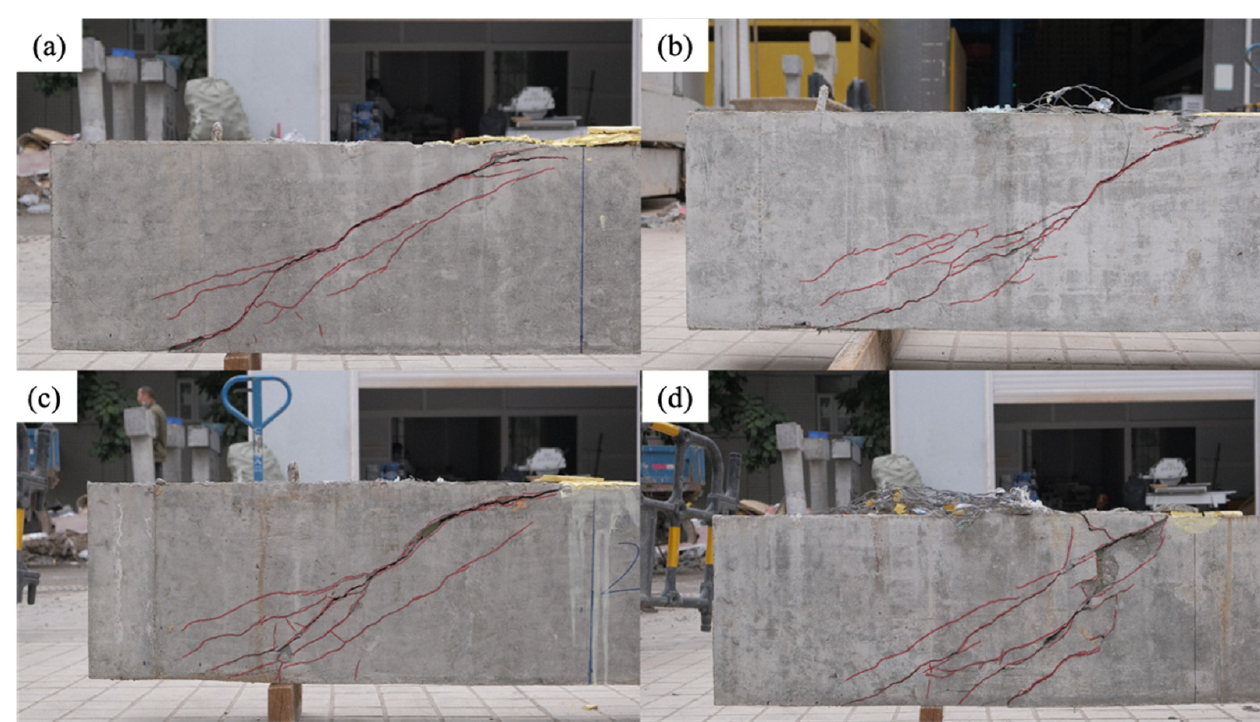
Figure 6. Failure mode for specimen: ( a ) reference; ( b ) 20 × 30 @ 200; ( c ) 20 × 30 @ 150; and ( d ) 20 × 30 @ 100.